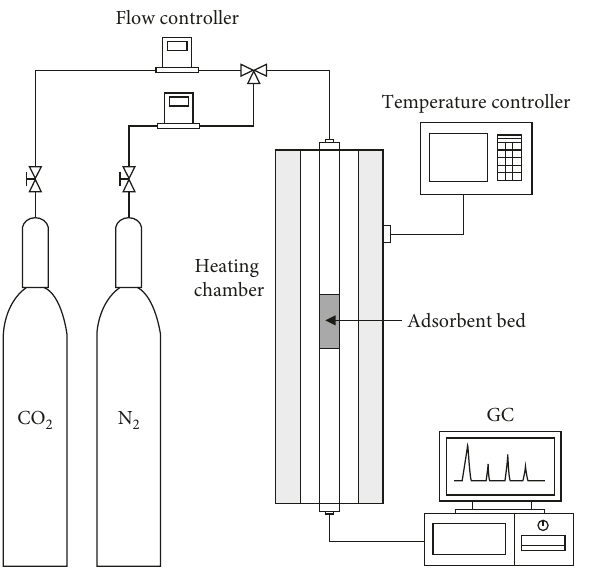
Figure 1: Schematic diagram of the CO 2 adsorption system. Figure 2: XRD patterns of MgO with different TEPA